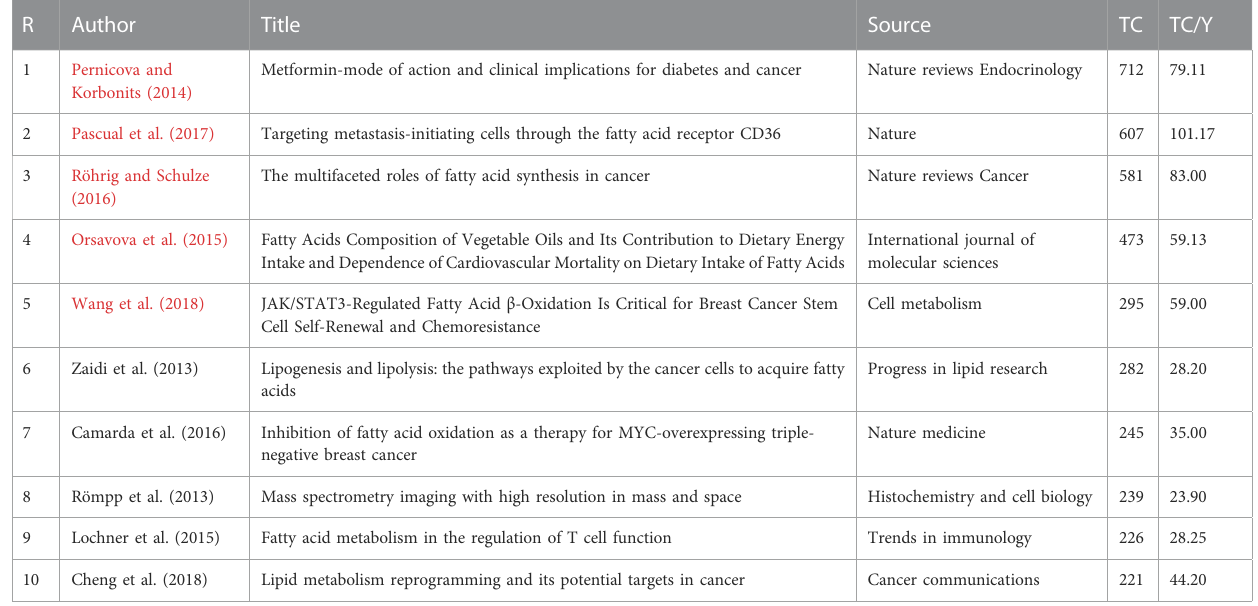
TABLE 1 Top 10 cited documents in the fi